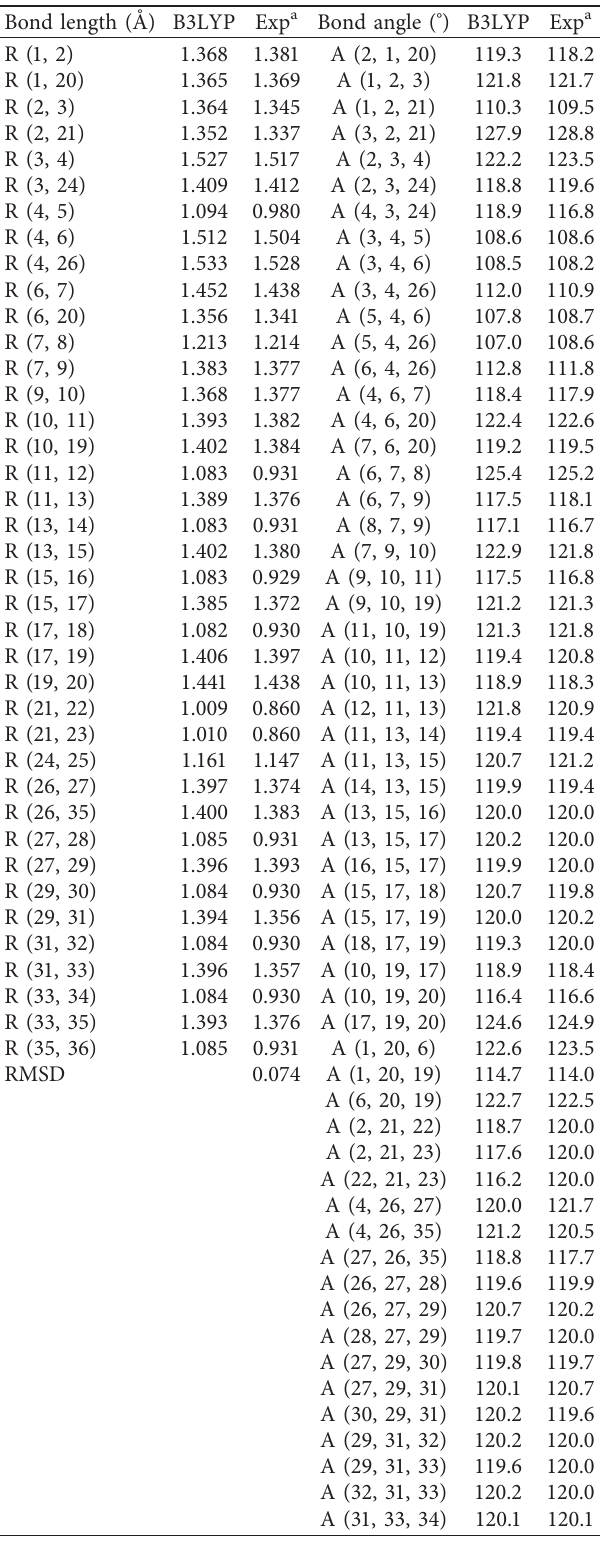
Table 1: Structural parameters of Chrom-D optimized at the B3LYP/6-311++G(d,p) level of theory compared to the experi- mental data.